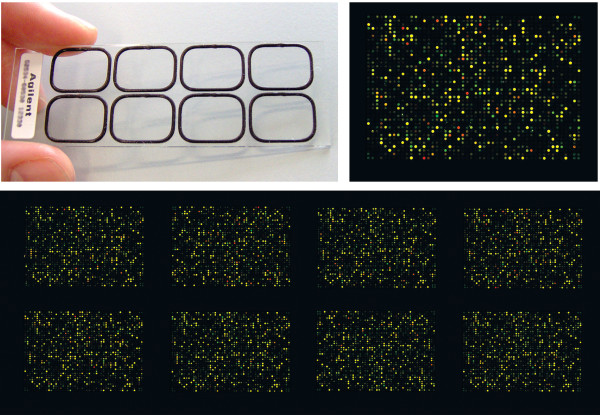
MammaPrint 8-pack, a single 1" × 3" slide containing 8 mini-arrays with 1,900 60-mer oligonucleotide probes, allowing for eight individual hybridizations simultaneously. The samples are hybridized against a common breast cancer reference pool.